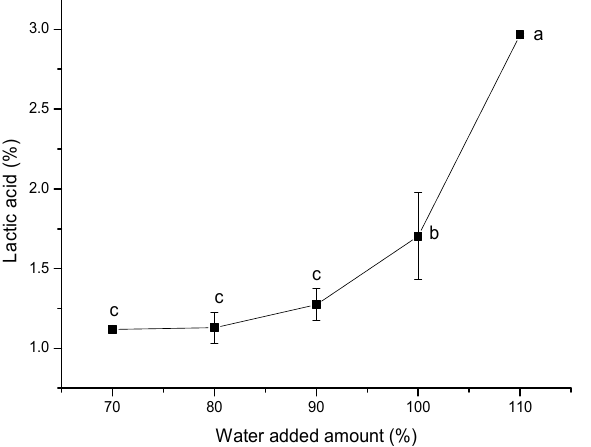
Figure 2. The single-factor experiments for the water addition amount with Pediococcus acidilactici. Experiments were performed in triplicate (n = 3). Sites not sharing a common letter showed significant differences ( p < 0.05).